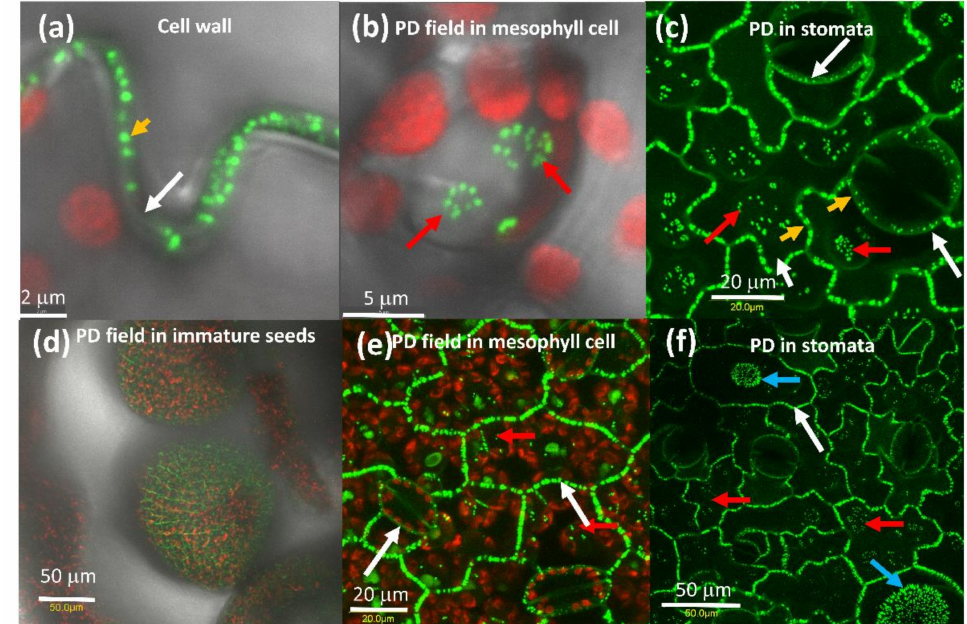
Figure 1. Distribution of PDLP5-GFP tobacco leaf cells. ( a ) Close-up of the tobacco cell wall between adjacent epidermis cells, ( b ) close-up of tobacco mesophyll cell pit field, the red globes are chloroplasts. ( c ) Close-up of stomata in tobacco leaf, ( d ) PD in immature tomato seeds, ( e ) tomato mesophyll cells, ( f ) stomata, and the base of trichomes in tomato leaf. A white arrow marks the cell wall, red arrow pit fields, yellow arrow points to a single PD, and a blue arrow points to pit fields at the base of trichomes. The bar shows the distance in µ m.